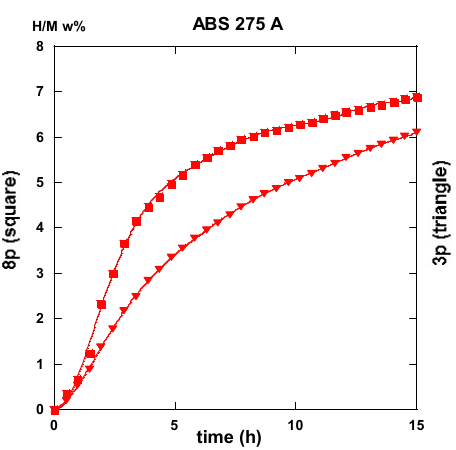
Figure 24. Hydrogen absorption rate (H/M w%) versus time at 275 °C (red) for 3 passes (triangles).